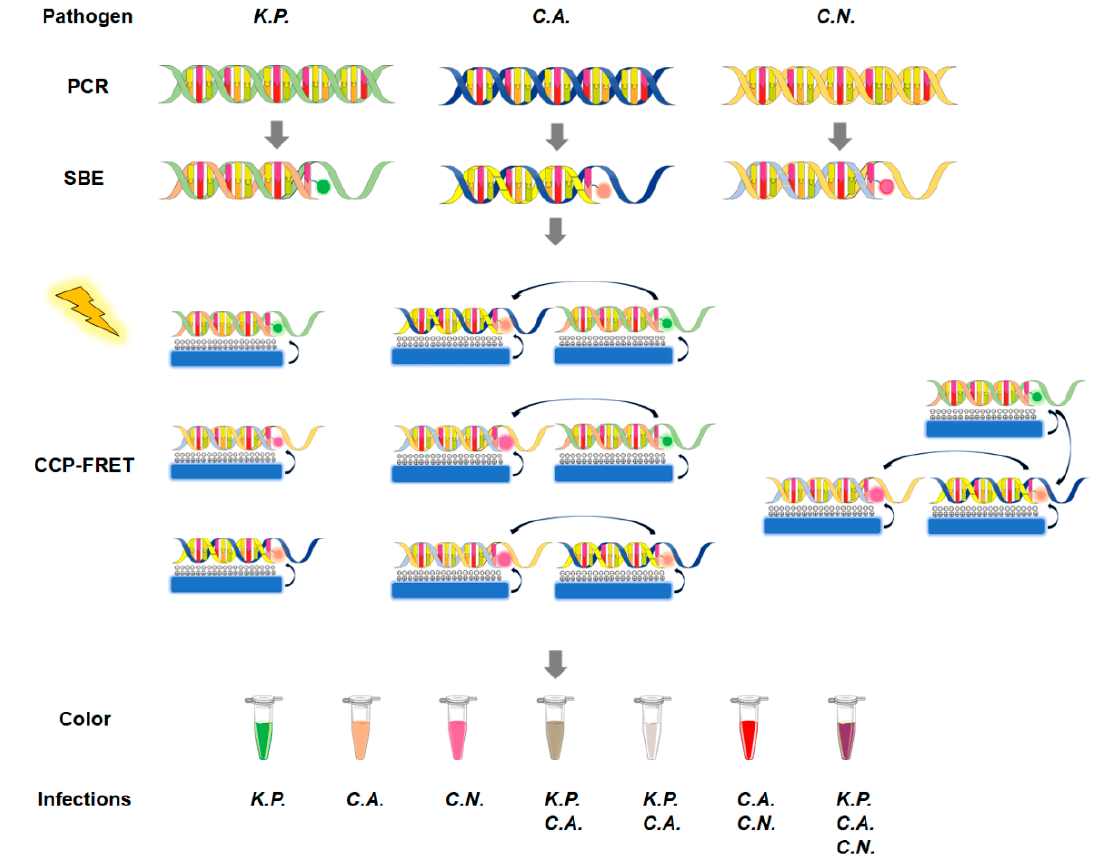
Figure 1. Schematic illustration of the CCP-FRET system. The ITS DNA of the three pathogens is enriched through regular PCR and then the dye-ddNTPs are connected to the specific DNA fragments by a single-base extension (SBE) reaction. The CCP-FRET reaction is triggered by 380 nm UV light and CCP acts as an energy donor to activate the pathogen-specific DNA labeled with fluorescent dyes. In